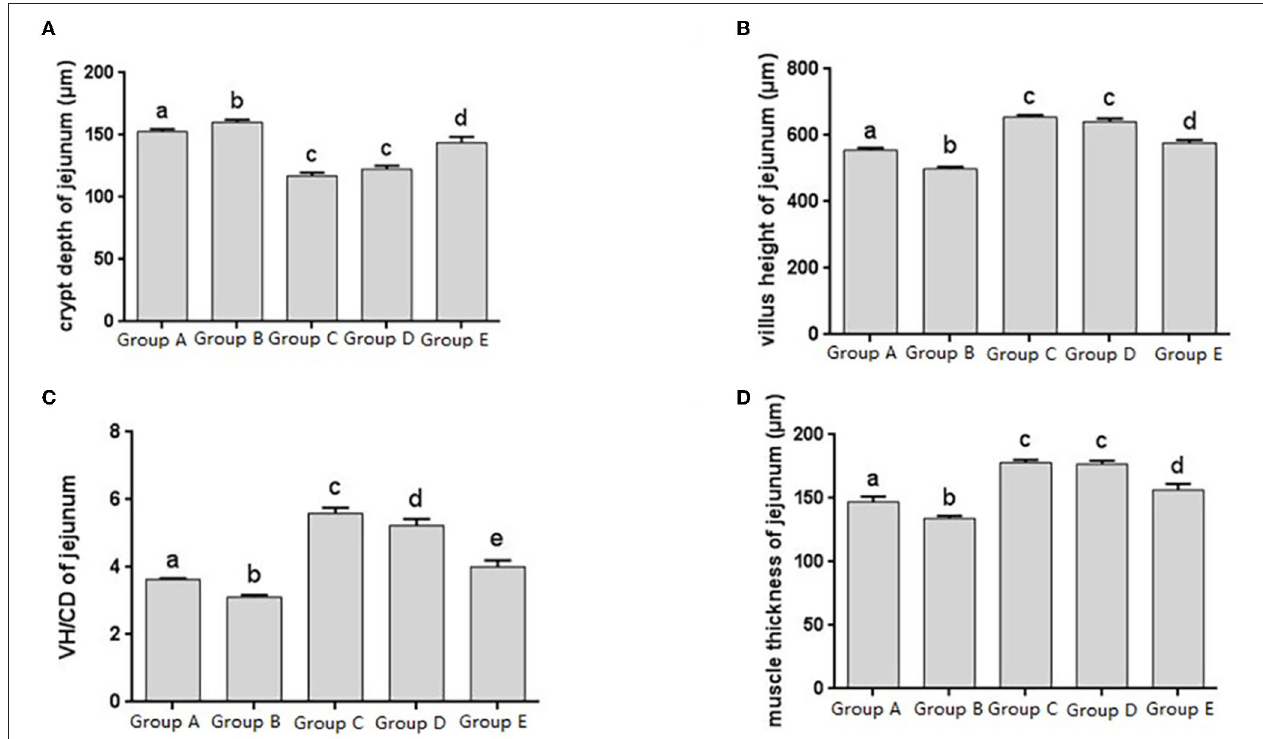
FIGURE 3 | Morphological changes in the jejunm of chicks after different treatments. (A) Crypt Depth (CD) of jejunum. (B) Villus height (VH) of jejunum. (C) VH/CD of jejunum. (D) Muscle thickness of jejunum. Group A, control group; Group B, infection group; Group C, JYBR-190 pre-fed group; Group D, JYBR-190 fed group; Group E, antibiotic group. Data are expressed as mean ± standard deviation (SD). Different lowercase letters on the columns indicate significant differences ( P < 0.05); the same lowercase letters indicate no significant difference ( P >